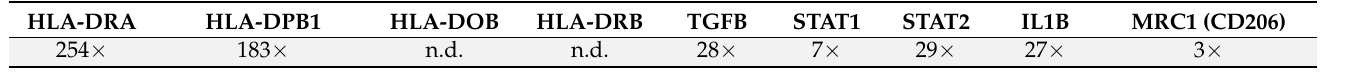
Values are depicted as fold-change in the patient sample versus non-disease control level. n.d. = not